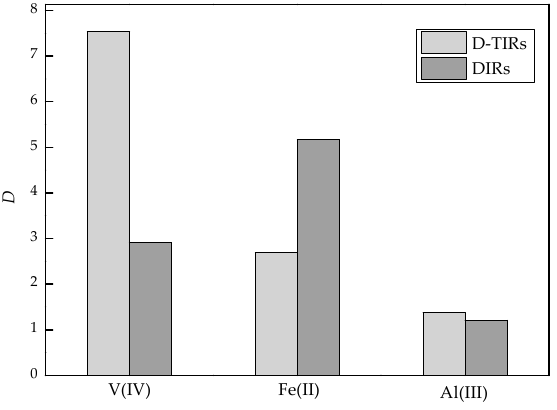
Figure 10. Distribution coefficient of V(IV), Fe(II), and Al(III) onto resins.